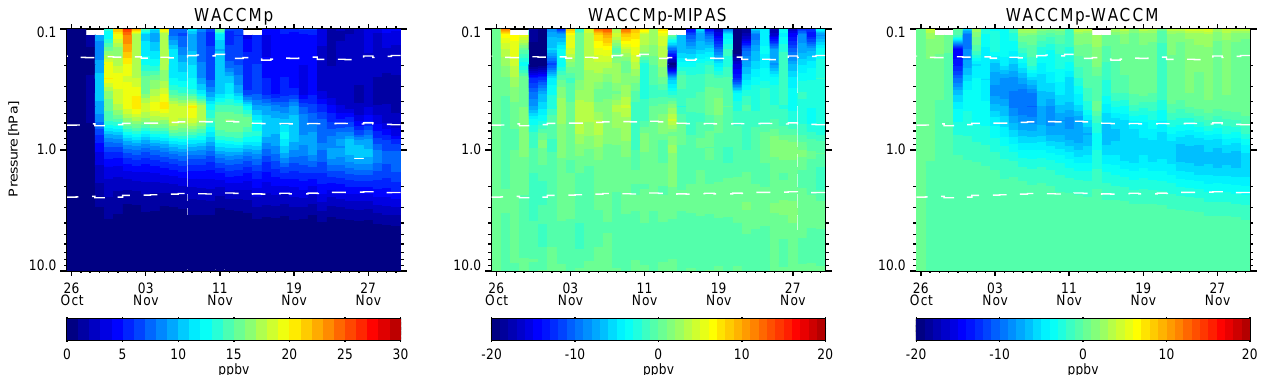
Fig. 16. As Fig. 15, but showing area-weighted averages for WACCMp (proton ionization, only, left), differences between WACCMp and MIPAS (middle), and differences between WACCMp and WACCM (right).